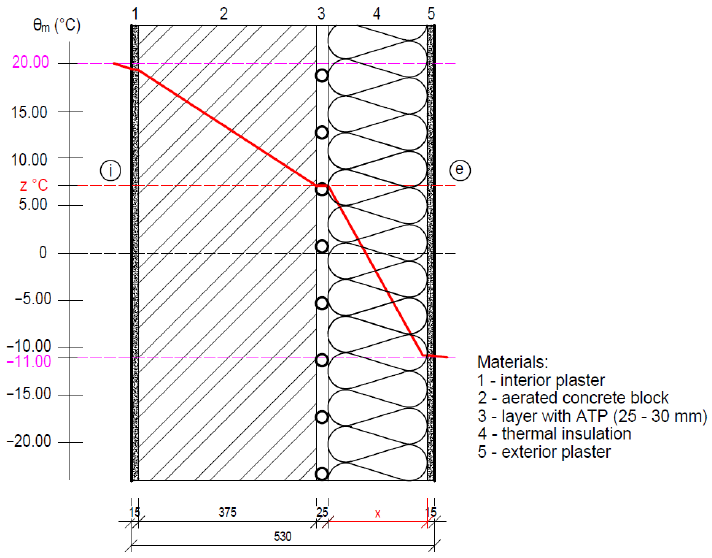
Figure 23. The mathematical-physical model for calculating the dynamic thermal resistance for var- ying thicknesses of static thermal insulation. θ m —the temperature in construction (°C), x—thickness of thermal insulation (mm), z—the temperature between the load-bearing and thermal insulation layer of the structure (°C), e—exterior, and i—interior.